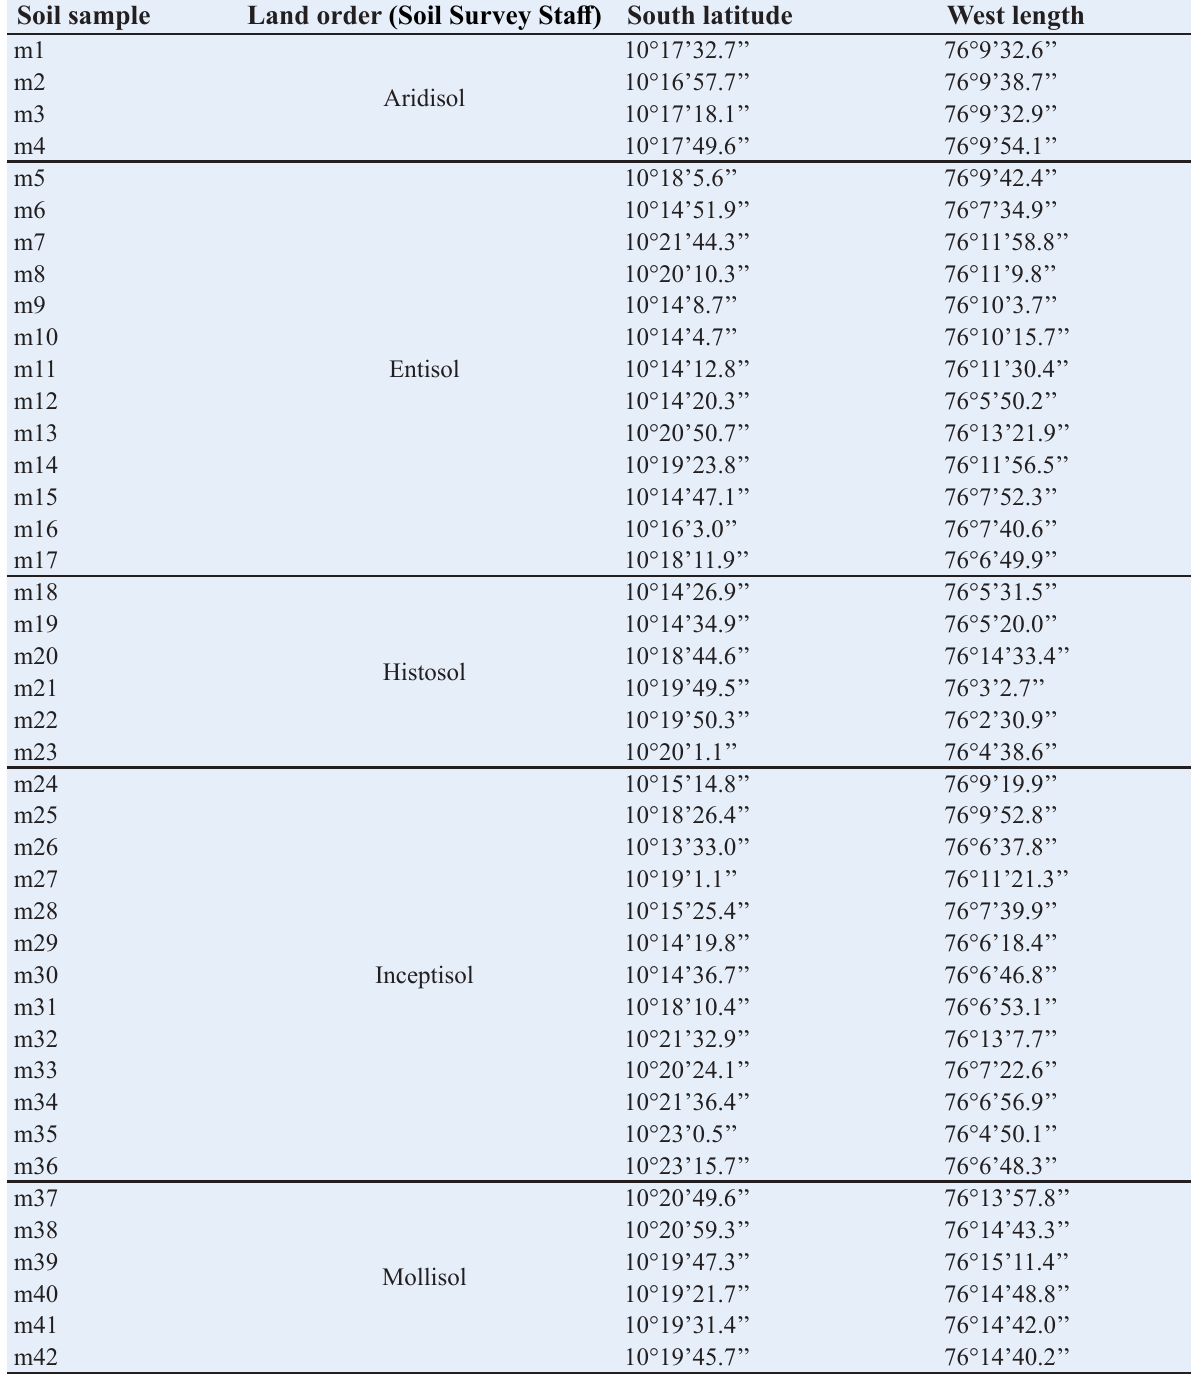
Table 1: Location of the sampled